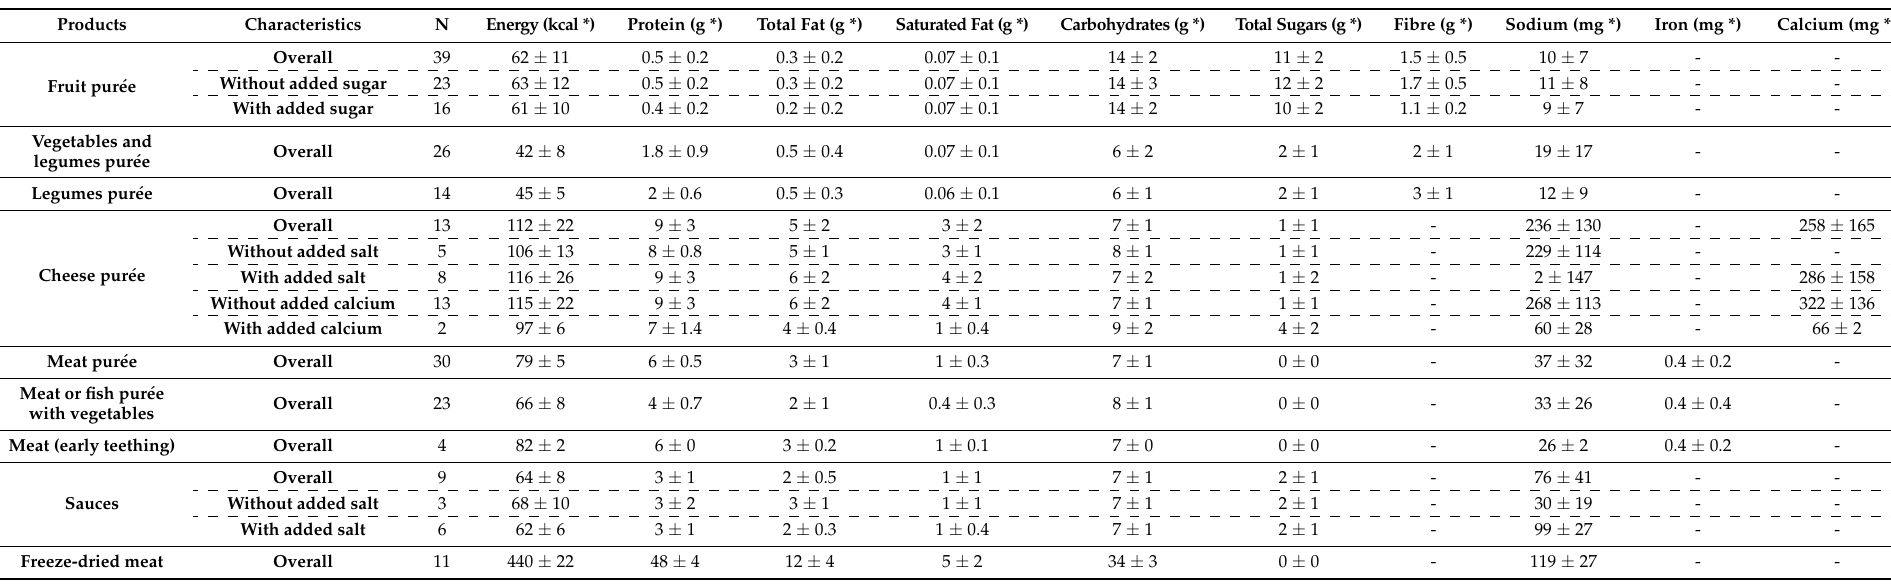
Table 2. Nutritional analysis of commercial baby food available in Italy. * Values are expressed as M ± SD as g or mg/100 g or mL of